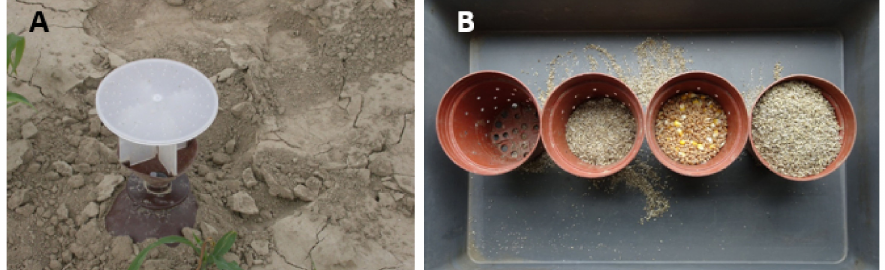
Figure 3. Illustrations of trapping systems. ( A ) Click-beetle pheromone trap YATLORF. ( B ) Wireworm bait trap (right pot) and sequential filling of the trap with an empty trap (left pot), a trap with a layer of vermiculite (second pot from left), a trap with a layer of vermiculite and a layer of germinating maize and wheat (second pot from the